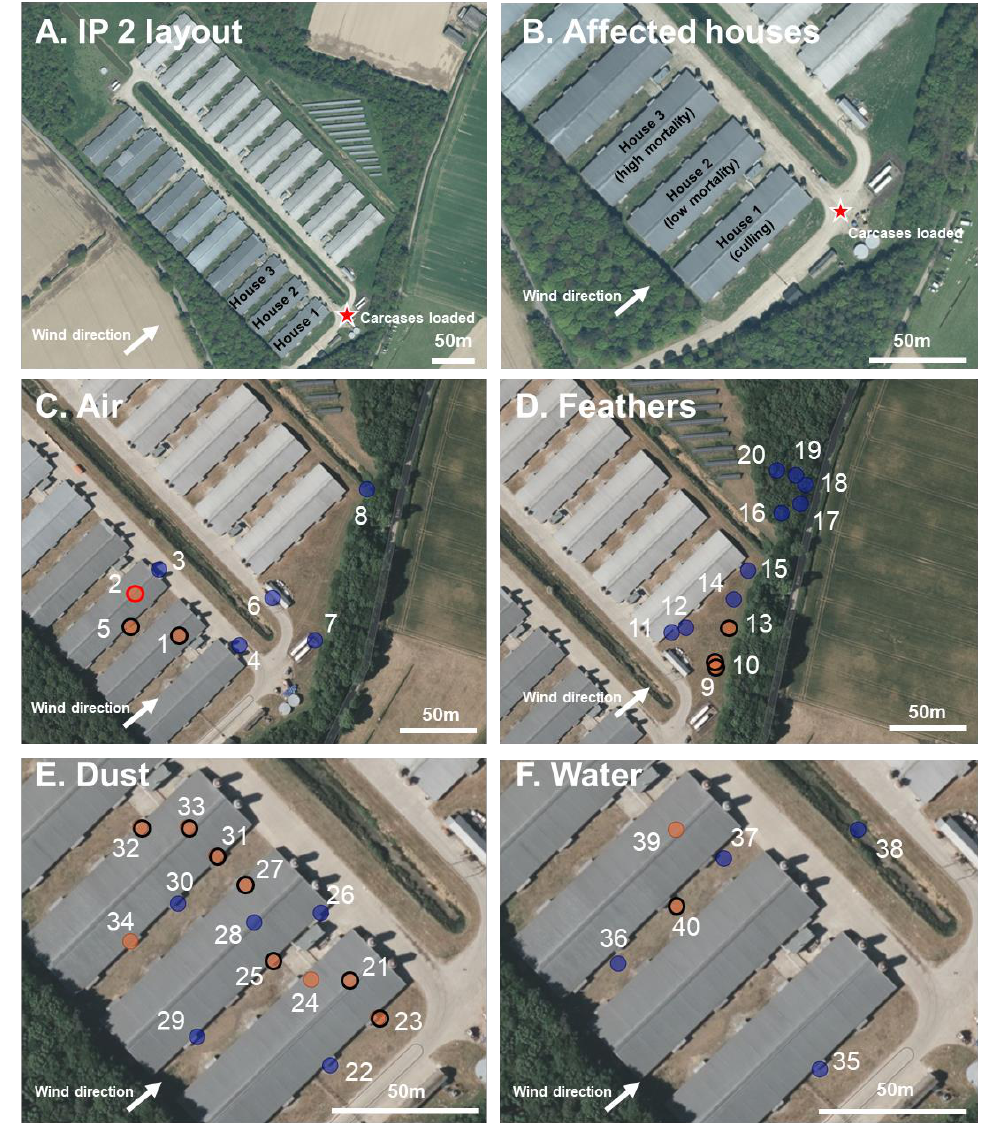
Figure 2. Infected premises 2 (IP2): Environmental sampling and presence or absence of H5 HPAIV RNA at a turkey IP. ( A , B ). Map showing the layout of the IP with the three affected houses indicated, wind direction at time of sampling, the site where carcasses were loaded onto trucks (red star), and mortality and culling indicated. ( C – F ). The location of the environmental sampling and H5 RRT-PCR results showing the presence (orange) or absence (blue) of H5 HPAIV RNA in the sample and the positive isolation of infectious virus (red outline) or negative isolation of infectious virus (black outline). Samples were collected from air filters ( C ), feathers ( D ), dust ( E ), and water ( F ). Op swabs from dead turkeys are not shown but indicated in Table S2.